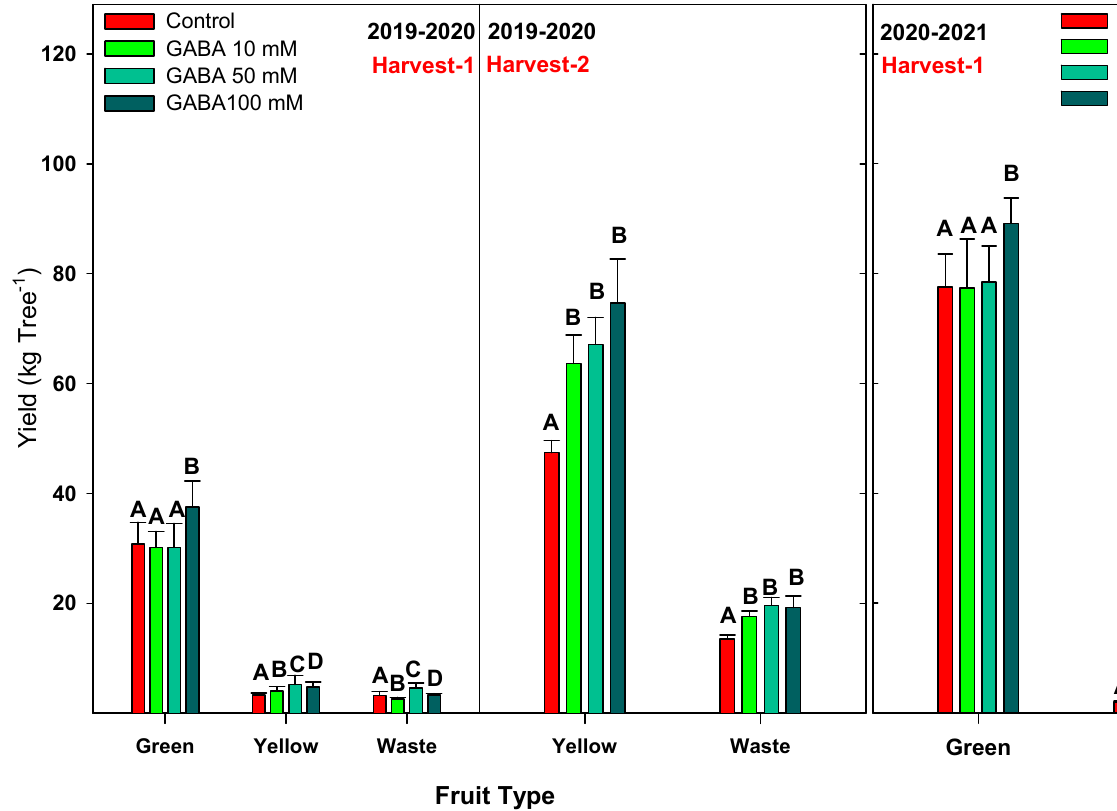
Figure 3. Crop yield (kg tree − 1 ) for the two harvest dates and two seasons as affected by GABA treatment and according to different categories. Data are the mean ± SE. Different letters (A, B, C, and D) on the bars denote significant differences at p < 0.05 among treatments for each fruit type.